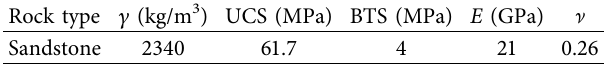
Table 1: Mechanical characteristics of